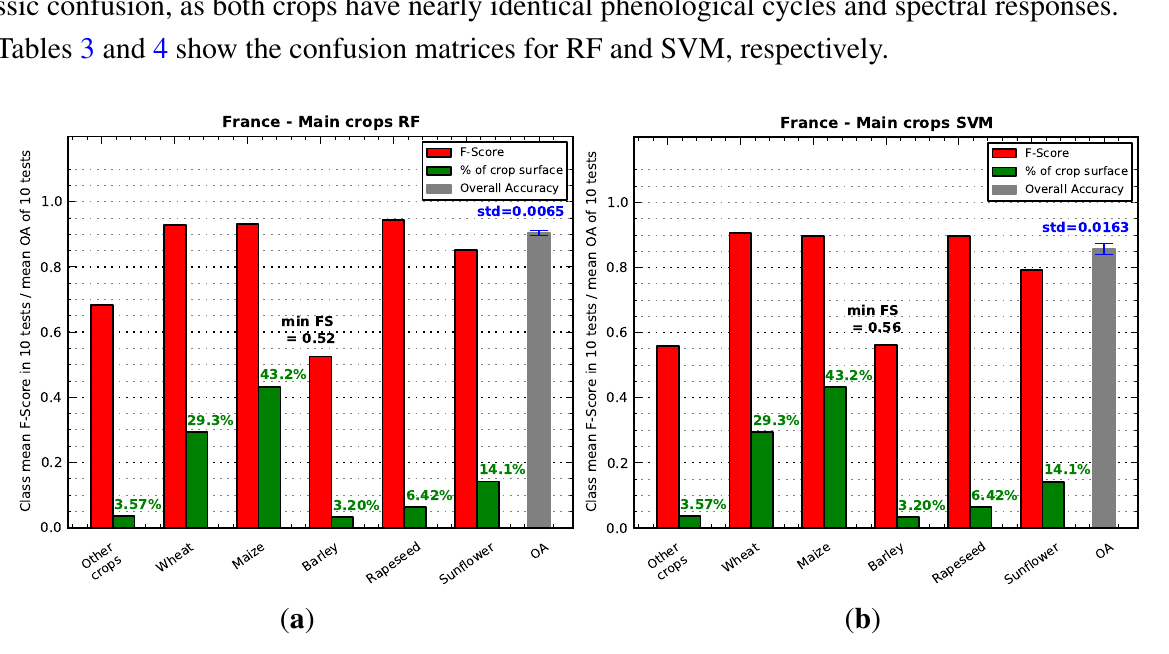
Figure 4. F-score and OA results for RF and SVM for the France test site. ( a ) RF; ( b ) SVM. Table 3. Confusion matrix for RF on the France test